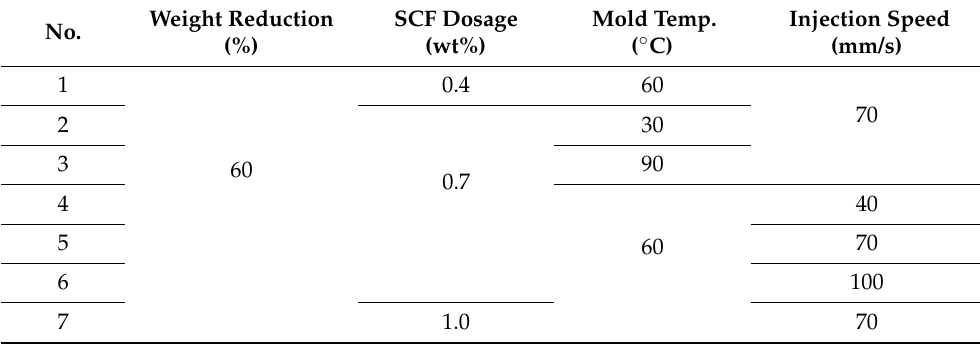
Figure 2. A typical SEM image for measuring foaming bubbles photographed at P1, P2, and P3. A typical foaming morphology at P2 location is illustrated. Table 2. Processing parameters (traditional MuCell ® ).